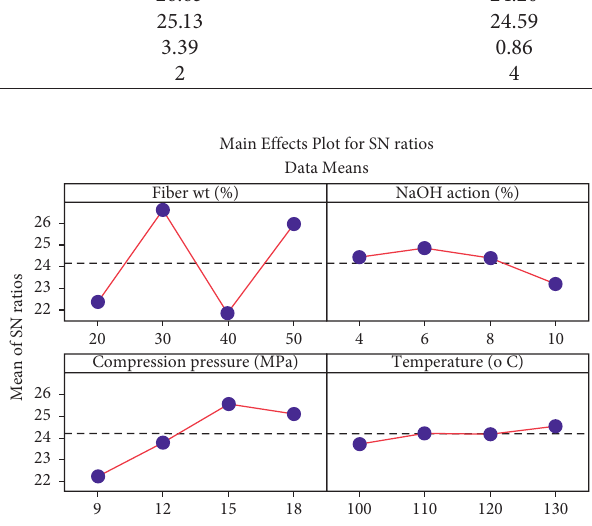
Figure 12: Main effect plot for means to impact strength. Figure 13: Main effect plot for means to impact strength.